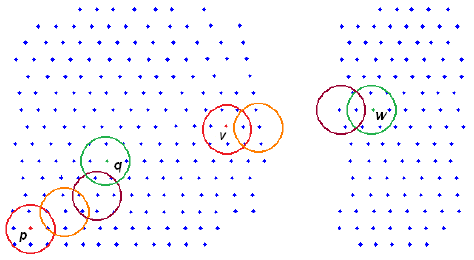
Figure 2: Definition of connected components. The points p and q are in the same component because there is a chain of overlap- ping r -balls connecting them. Because there are no such chains between the points v and w , they are in different components.